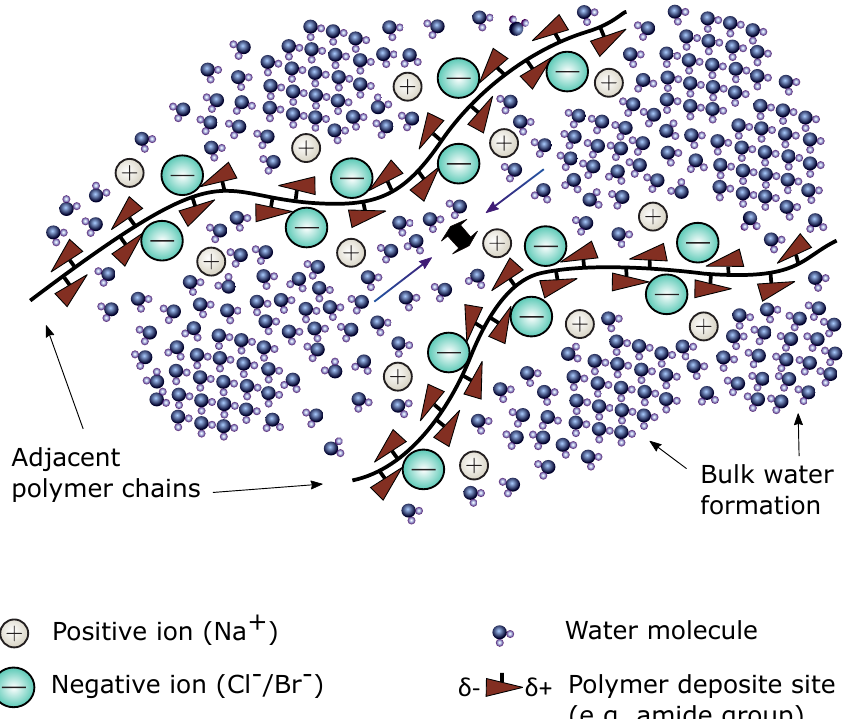
Figure 1. Schematic illustration of specific ion mechanism of Cl − / Br − ions interacting with polymers in aqueous solution. Adsorption of the anions to the polymer chains is aided by rejection of water molecules that favor bulk water structure formation. Cl − and Br − , as large monovalent ions with low charge density, interacts weakly with water molecules, thus interfering only modestly with the hydrogen bonding of the surrounding water, whereas Na + , a small ion with high charge density, exhibits stronger interactions with water molecules and is capable of breaking water-water hydrogen